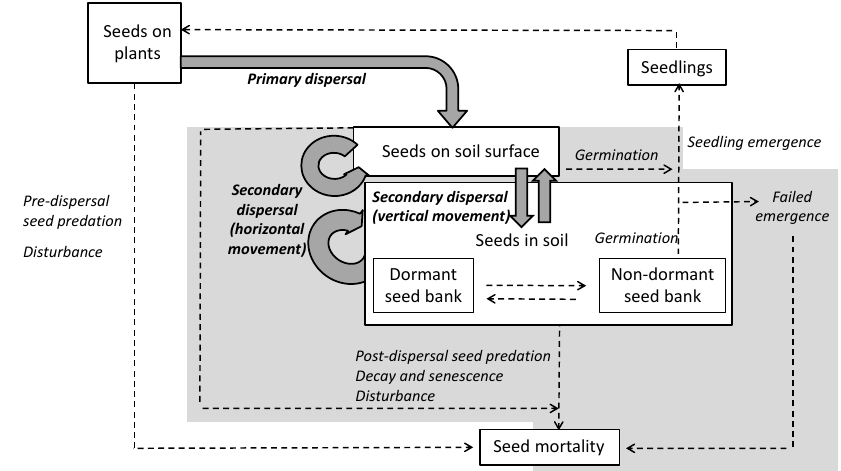
Figure 4. Conceptual model of seed fate in and on the soil (grey area). Rectangles represent seed states, dotted arrows indicate transitions between seed states, and processes are written in italics. Grey arrows indicate seed movements, and processes related to movement are in bold. After Schafer and Chilcote (1970), Fenner (1985), Chambers and Mac Mahon (1994) and Van der Wall et al. (2002). The term “seed” used throughout the model and the text represents the diaspore or unit of dispersal (seed with surrounding dispersal